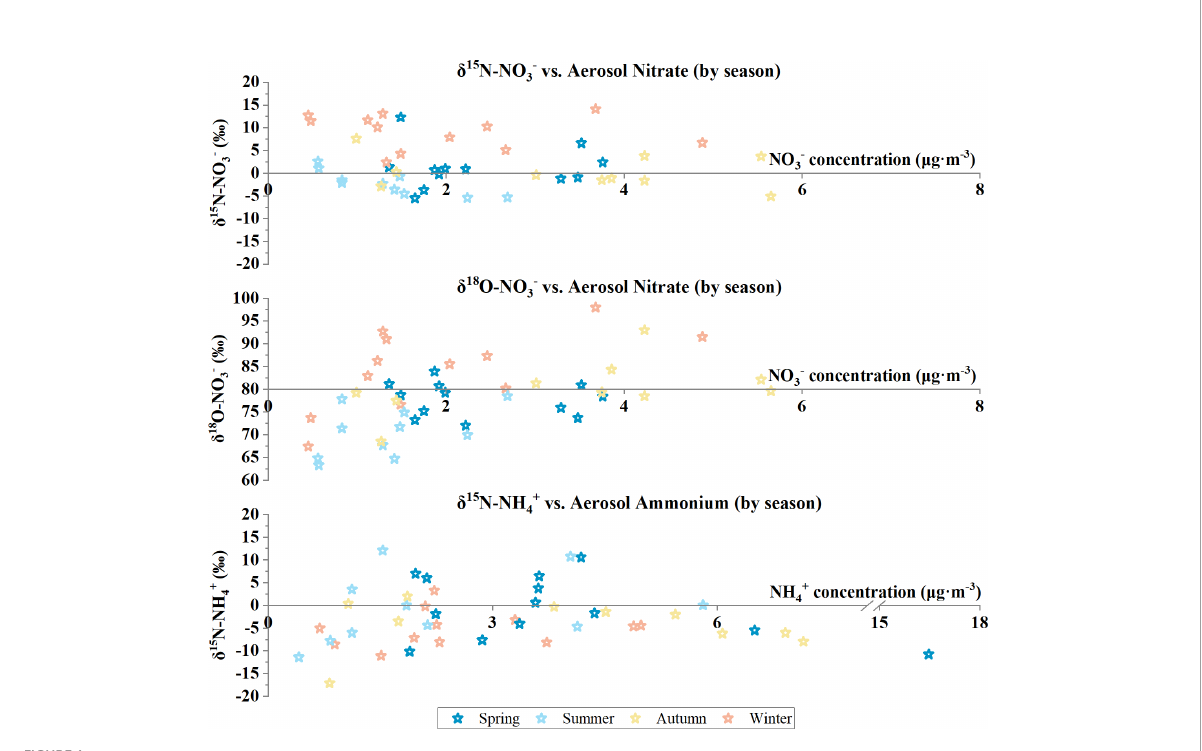
FIGURE 1 Aerosol nitrate and ammonium isotopic compositions plotted against aerosol nitrate and ammonium concentrations with samples coded by seasons at the Qianliyan Island in